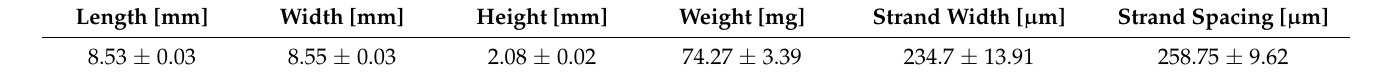
Figure 1. Overview of the 3D printed Scaffolds; ( a ): CAD model; ( b ): two layers of the 3D printed scaffold, image taken directly while printing from the Envisiontec 3D Bioplotter; ( c ): 3D Laserscan Image of the scaffolds; ( d ): 3D reconstruction of the 3D lasaerscanning microscopy data. Table 2. Size, weight and strand width of the 3D printed PCL scaffolds ( n =